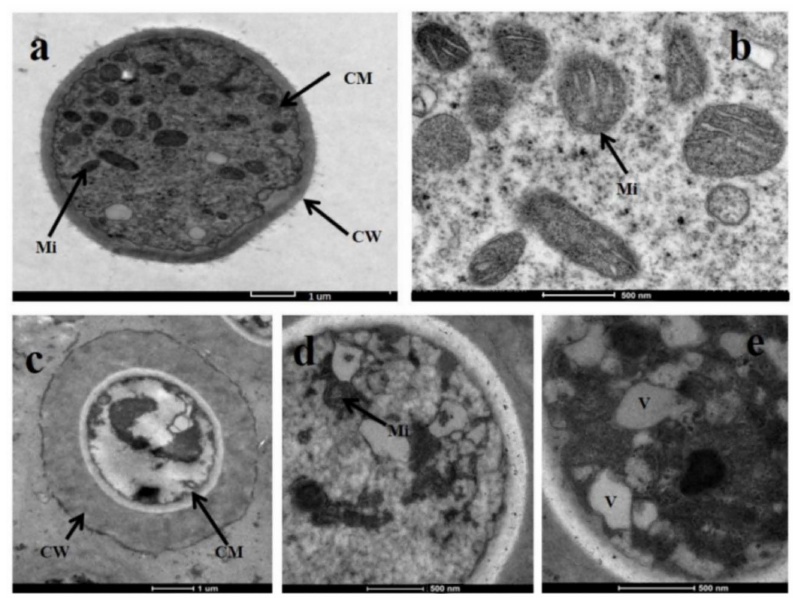
Figure 3. Ultrastructure of S. sclerotiorum mycelia by transmission electron microscopy in untreated control ( a , b ) and treated with 10 µ g/mL glabridin ( c – e ). CW: Cell wall; CM: Cell membrane; Mi: mitochondrion; V: vacuole. The scale bar in each subfigure: ( a ) 1 µ m; ( b ) 500 nm; ( c ) 1 µ m; ( d ) 500 nm; ( e ) 500 nm.